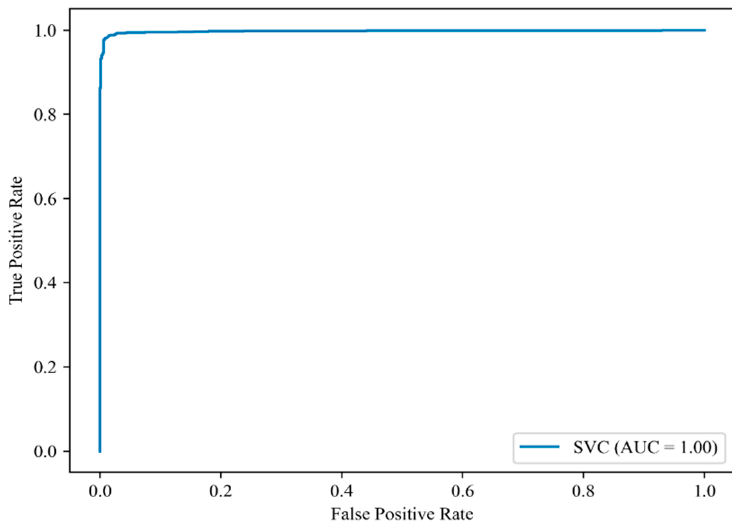
Figure 11. SVM testing confusion matrix (RBF kernel).